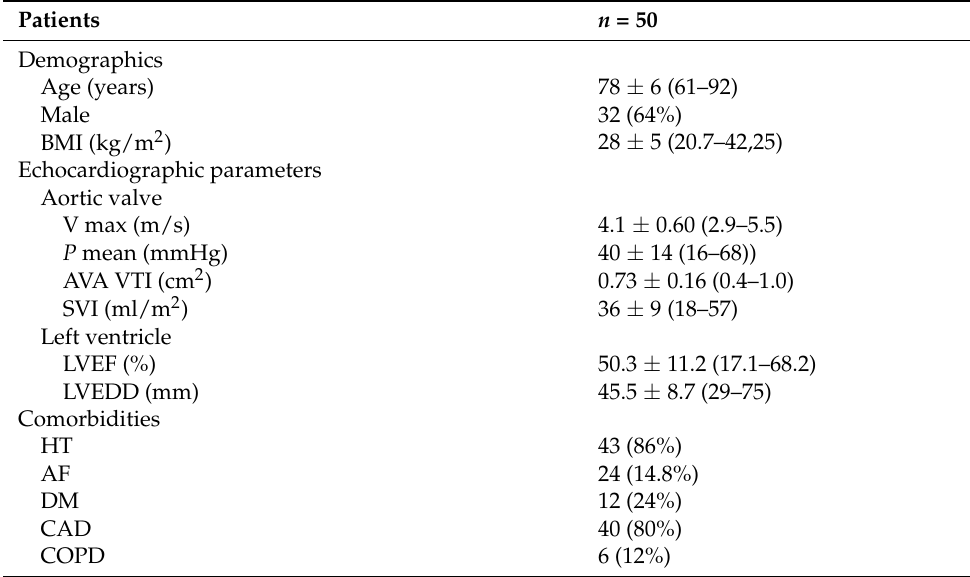
Table 1. The patients’ demographic and baseline characteristics.